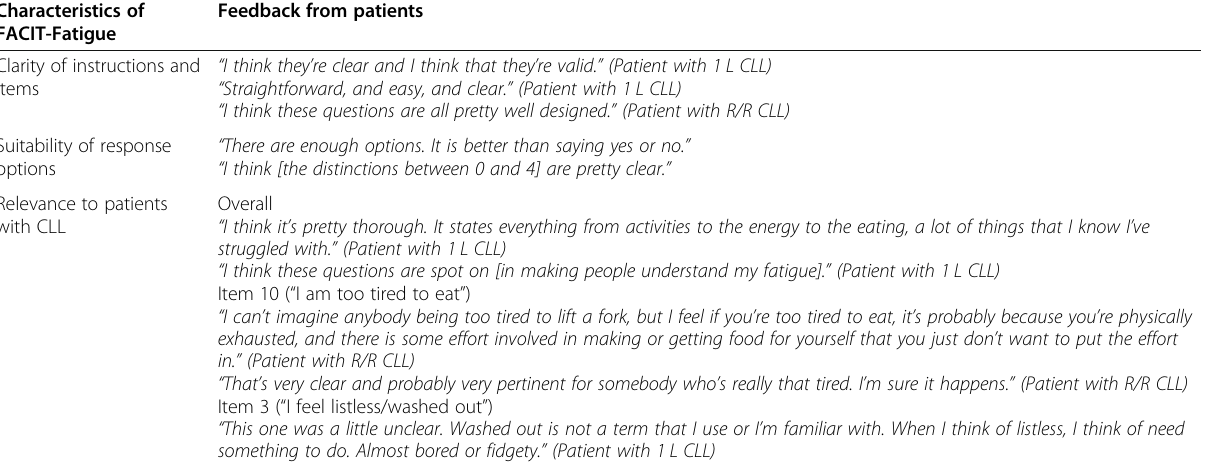
Table 1 Selection of feedback on the FACIT-Fatigue from patients with CLL Characteristics of